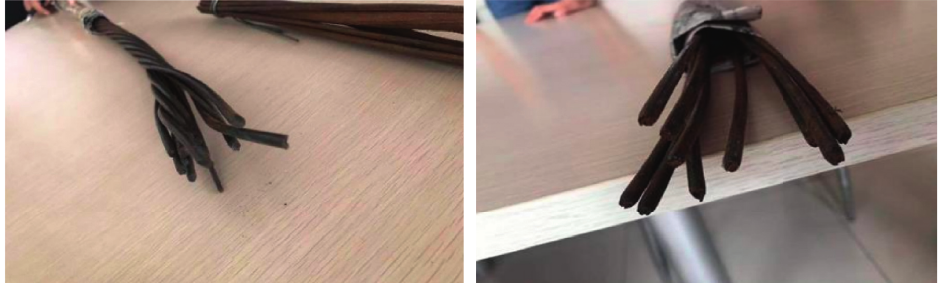
Figure 2: Cable breakage of No. 3 exploration roadway.